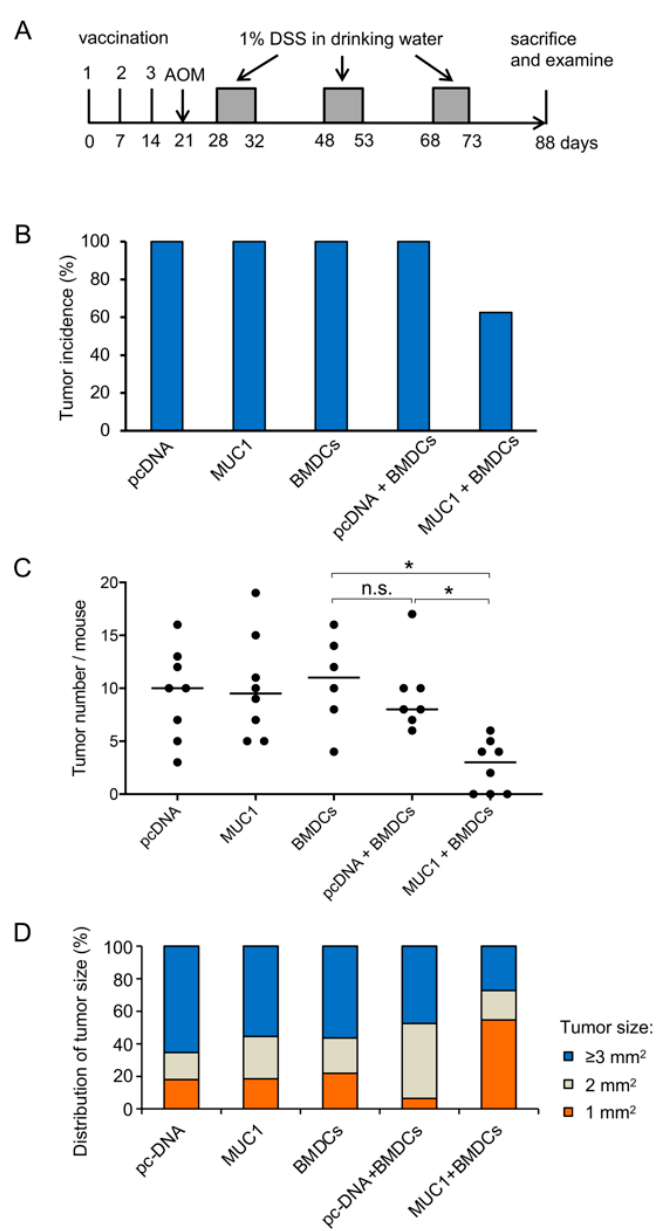
Figure 3. Efficacy evaluation of vaccination in MUC1.Tg mice after azoxymethane-dextran sulfate sodium (AOM-DSS) treatment. ( A ) Experimental protocol. MUC1.Tg mice were divided into five groups and vaccinated with the following: (1) mock plasmid (pcDNA), (2) MUC1 plasmid (MUC1), (3) BMDCs (BMDCs), (4) pcDNA mixed with BMDCs (pcDNA + BMDCs), and (5) MUC1 + BMDCs, each followed by AOM-DSS treatment. Mice received three vaccinations at weekly intervals in the footpad with 100 µ g of MUC1 DNA dissolved in 50 µ L of Hanks’ Balanced Salt Solution mixed with or without 5 × 10 5 BMDCs per mouse, per vaccination. One week following the third vaccination, azoxymethane (AOM) was injected at 10 mg/kg body weight in the intraperitoneal site, followed by periodical administration of 1% ( w / v ) dextran sulfate sodium (DSS) in drinking water. Mice were sacrificed two weeks after the last DSS administration. ( B ) Tumor incidence in AOM-DSS-treated MUC1.Tg mice after vaccination, all groups are n = 10. ( C ) Number of tumors per mouse in vaccinated MUC1.Tg mice. Each dot represents one mouse. The horizontal bar represents median. ( D ) Distribution of tumor size in vaccinated mice. MUC1.Tg mice vaccinated with MUC1 + BMDCs showed a higher percentage of small (1 mm 2 ) tumors and a lower percentage of large ( ≥ 3 mm 2 ) tumors compared to all other groups. For statistical analysis in ( C ), the Steel–Dwass test was performed. * p < 0.05, n.s.: not